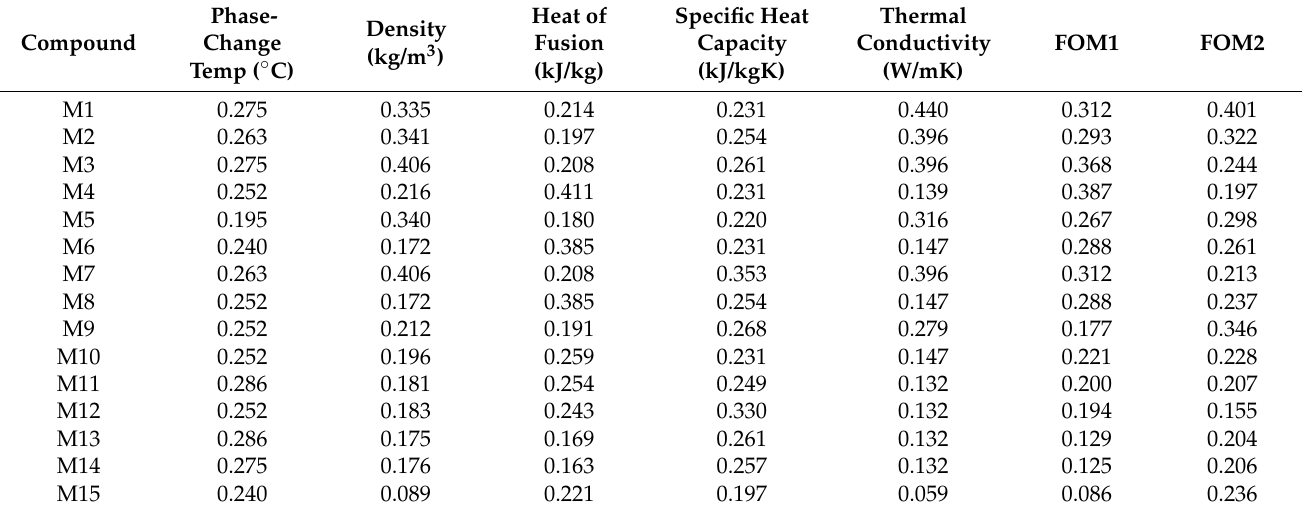
Table 12. TOPSIS normalized matrix.